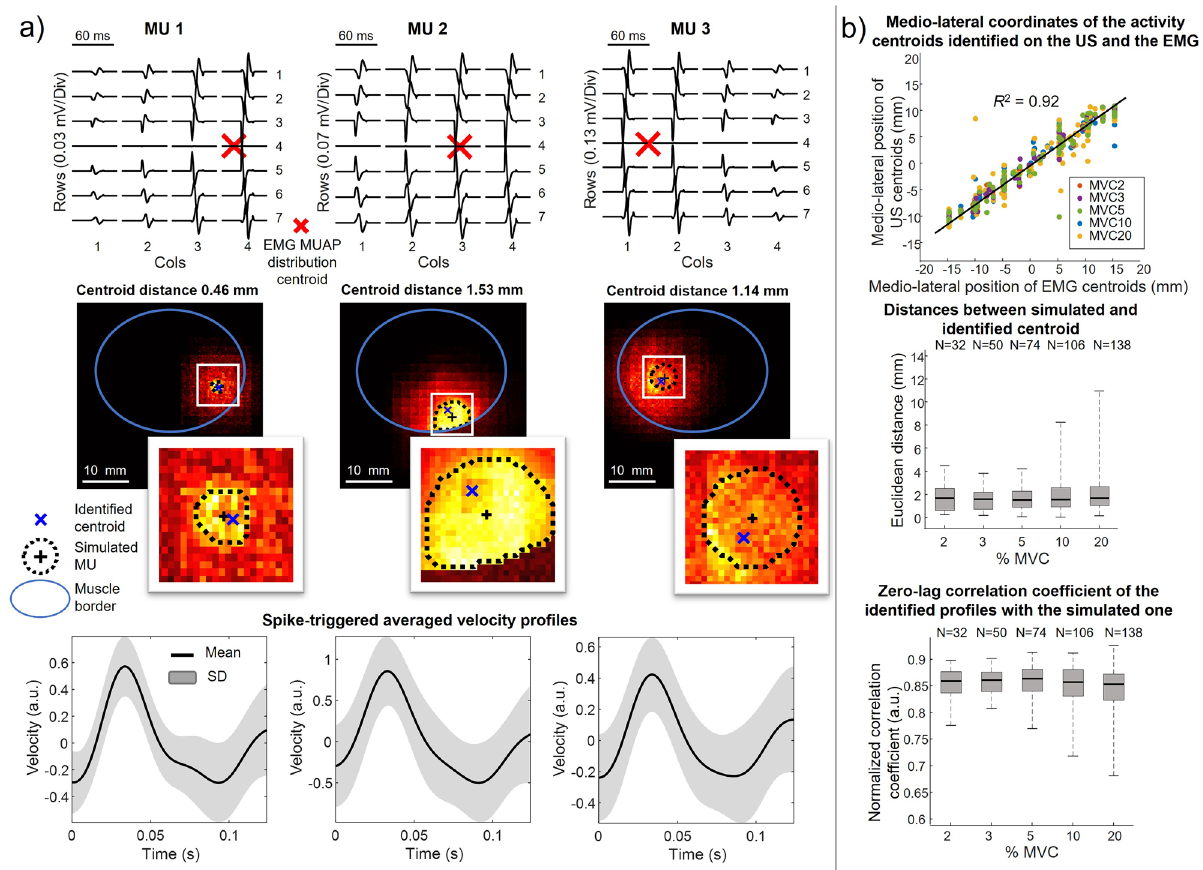
Figure 3. Simulation results. ( a ) Three representative outputs of the algorithm on simulated MUs. From top to bottom: longitudinal differential MUAP decomposed from EMG with the correspondent centroid (red cross); MU spatial representation in US images identified by the algorithm; a zoom of the simulated MU territory (MU center ‘+’ and contour in black dotted line) and the centroid of identified region (blue cross); mean (black solid line) and the standard deviation (grey band) of the spike-triggered averaged velocity profiles related to the correspondent identified region of tissue displacement. ( b ) Group results of all 400 simulated MUs. From top to bottom: scatterplot of the relation between the medio-lateral coordinates of the MUAP centroids (red cross) and the US centroids (blue cross); boxplots of the Euclidean distances (i.e. error) between the center of the simulated MU and the identified centroid over different simulated contractions; boxplots of the zero-lag correlation coefficient of the identified profile with the simulated velocity profile over different simulated